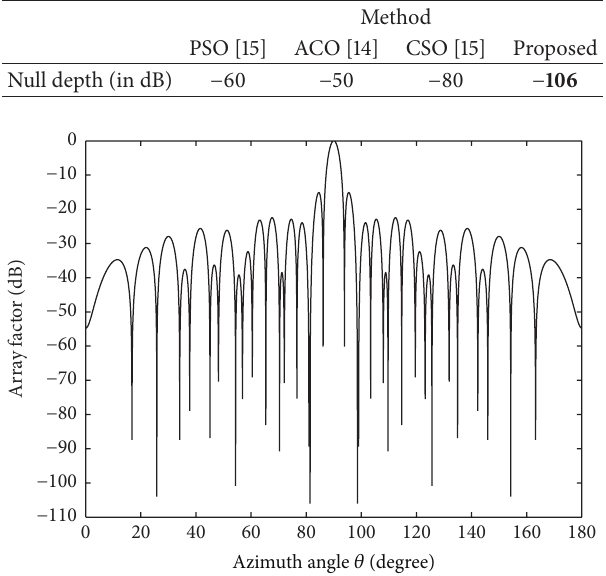
Table 8: Optimized positions of the positive half of the 10-element array of Example 4 .